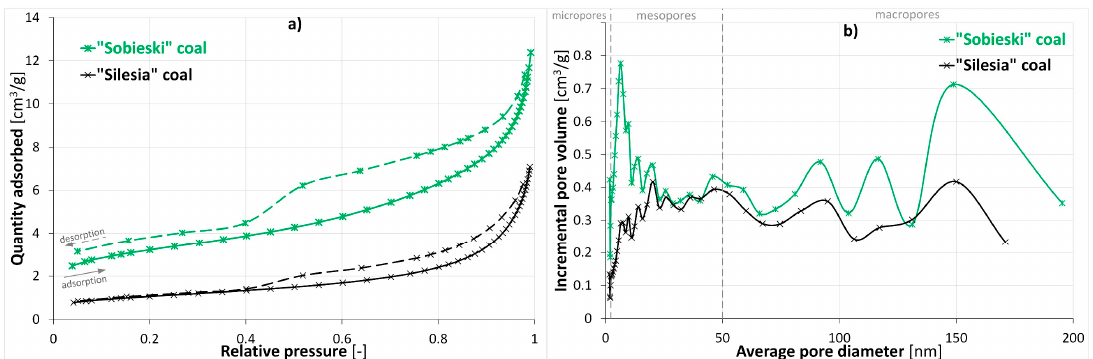
Figure 4. Results of low-pressure nitrogen adsorption (LPNA method) analysis of coals: ( a ) adsorp- tion and desorption isotherms; ( b ) pore size distribution as a function of average pore